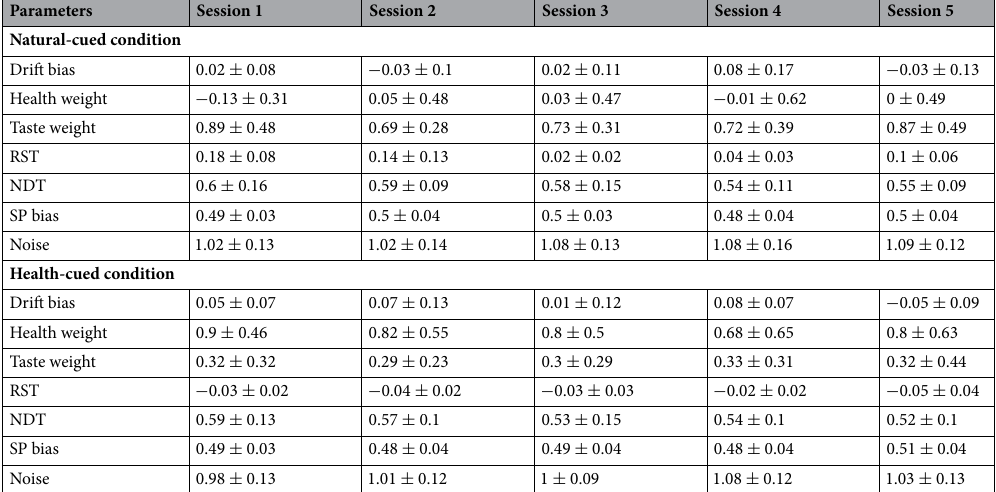
Table 1. rstDDM Parameters. This table reports the group-level estimates (mean ± standard error (SE)) for each of the rstDDM parameters over 5 sessions in both the natural-cued and health-cued conditions. The parameters are: stochastic component of evidence accumulation ( noise ), starting point bias ( SP bias ; a value of 0.5 indicate no starting point bias), non-decision time ( NDT ), relative start time for health ( RST ; computed as starting time for health minus starting time for taste), weight of taste attribute on drift rate ( taste ), weight of health attribute on drift rate ( health ), and intercept for drift rate ( Drift bias ). The decision thresholds were held fixed at [− 1, 1 ] when fitting the model.